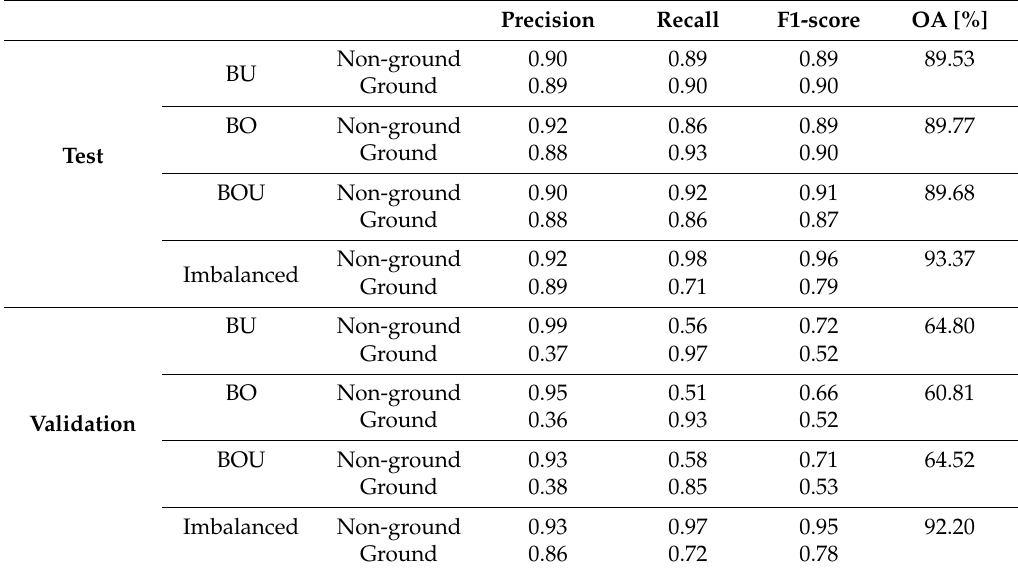
Table 4. Results of the accuracy assessment for the LiDAR datasets and the proposed